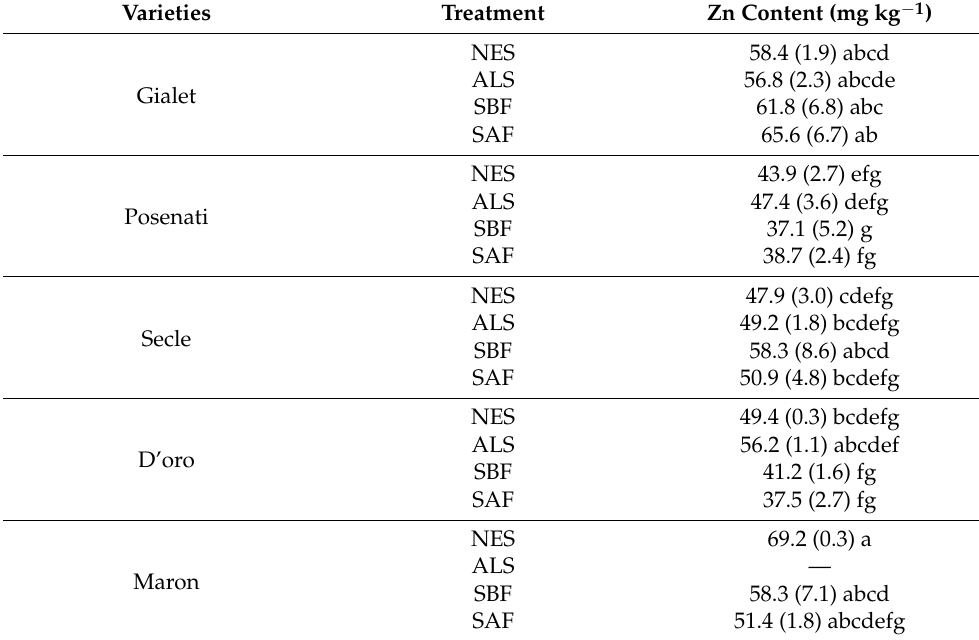
Table 3. Effects of varieties and treatment interaction on zinc content of Venetian bean ( P. vulgaris ) local varieties cultivated in a rain-out shelter between March and August 2020. Treatments were (1) never stressed (NES), (2) always stressed (ALS), (3) stressed before flowering (SBF), and (4) stressed after flowering